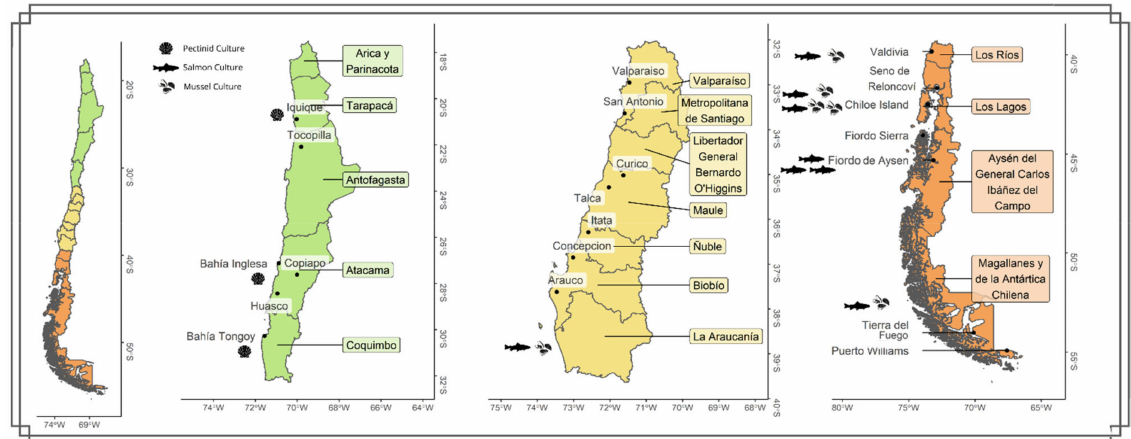
Figure 3. Map of Chilean political regions showing main aquaculture activities: Pectinids ( Argopecten purpuratus ), Mytilids ( Mytilus chilensis ), and Salmonids ( Oncorhynchus kisutch , Oncorhynchus mykiss , Salmo salar ).